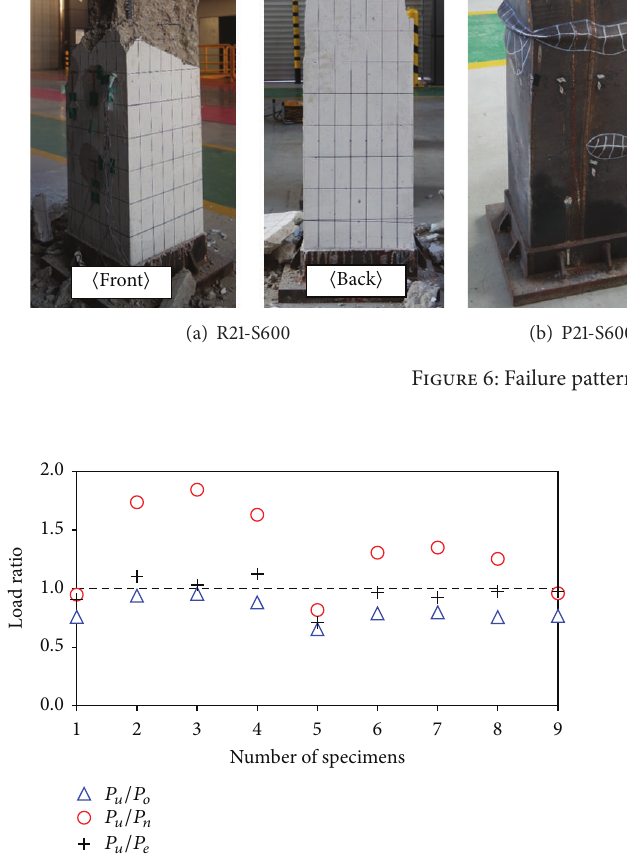
Figure 7: Comparisons of observed and calculated axial strengths of test specimens.